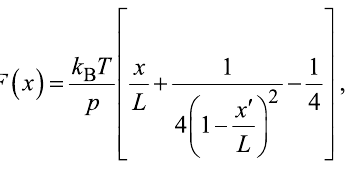
underlying fibril at P 2